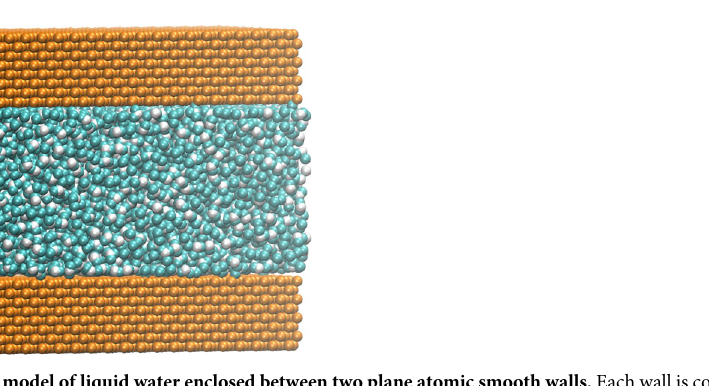
Fig 1. A simulation model of liquid water enclosed between two plane atomic smooth walls. Each wall is composed of 19,528 atoms. There are 4394 molecules comprising the liquid water.